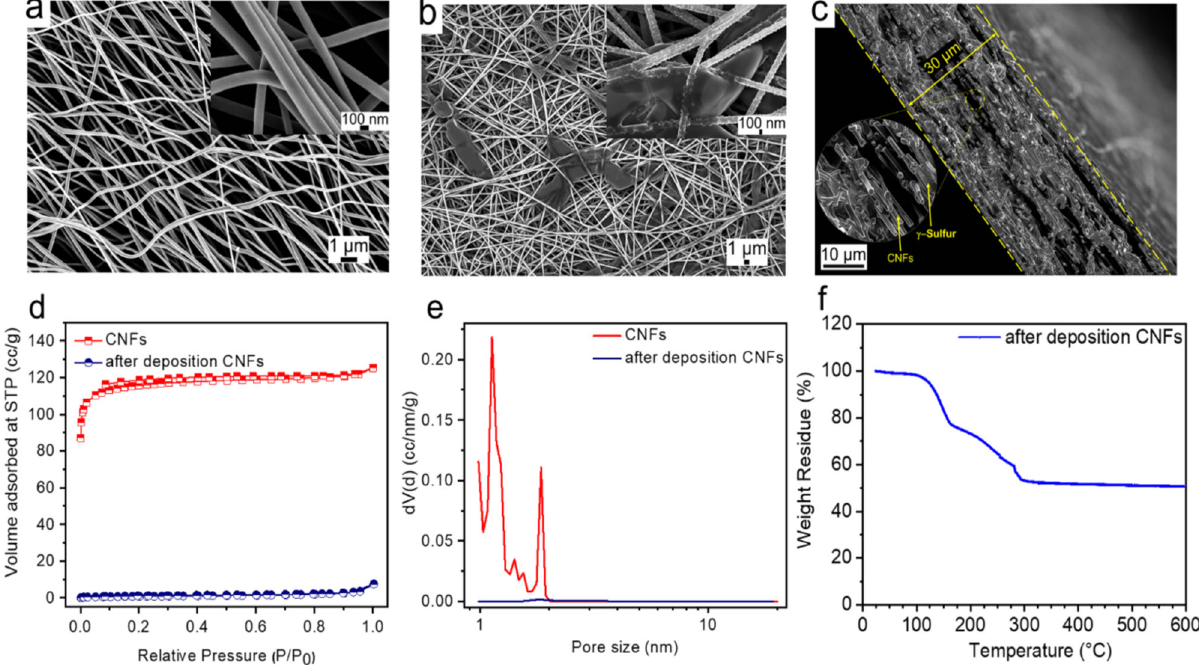
Fig. 2 Material characterization of CNFs. a SEM images of CNFs before deposition. b SEM images of CNFs after sulfur deposition, (inset) zoomed-in image of well-deposited sulfur particles of CNFs. c Cross-sectional SEM image of CNFs after deposition showing sulfur deposition throughout the cathode. d Isotherms obtained before and after sulfur deposition on CNFs. e The pore size distribution of CNFs before and after sulfur deposition. f TGA curves of sulfur deposited CNFs in an argon environment.